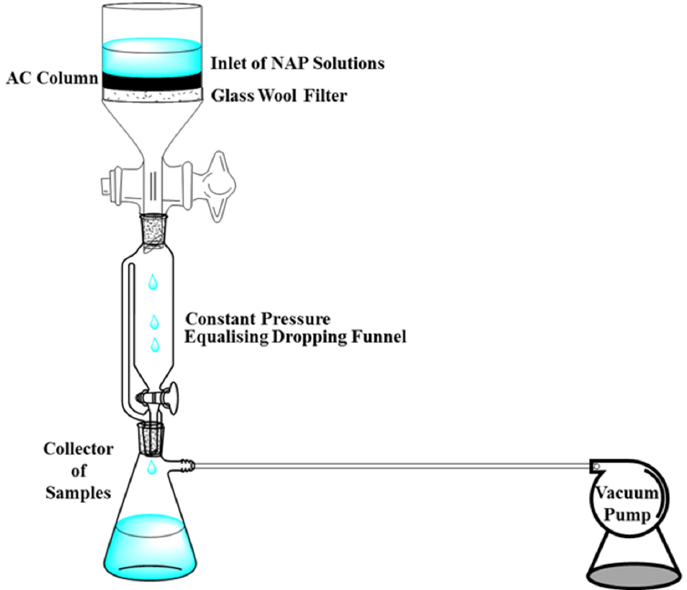
Figure 2. A schematic diagram showing the column adsorption of NAP.